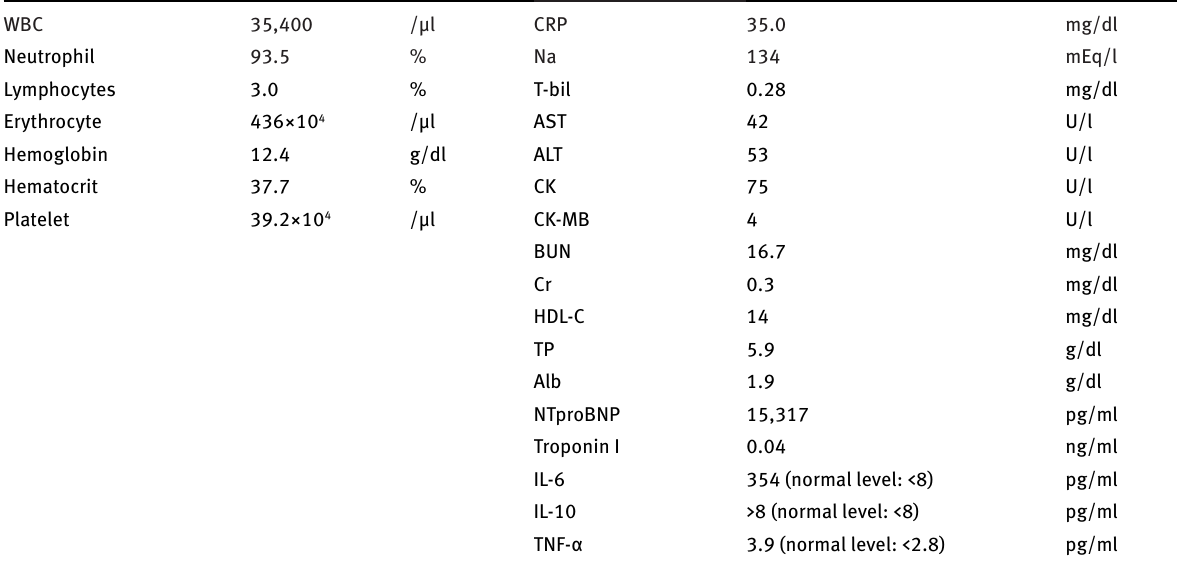
Table 1: Laboratory tests on 7 days of illness